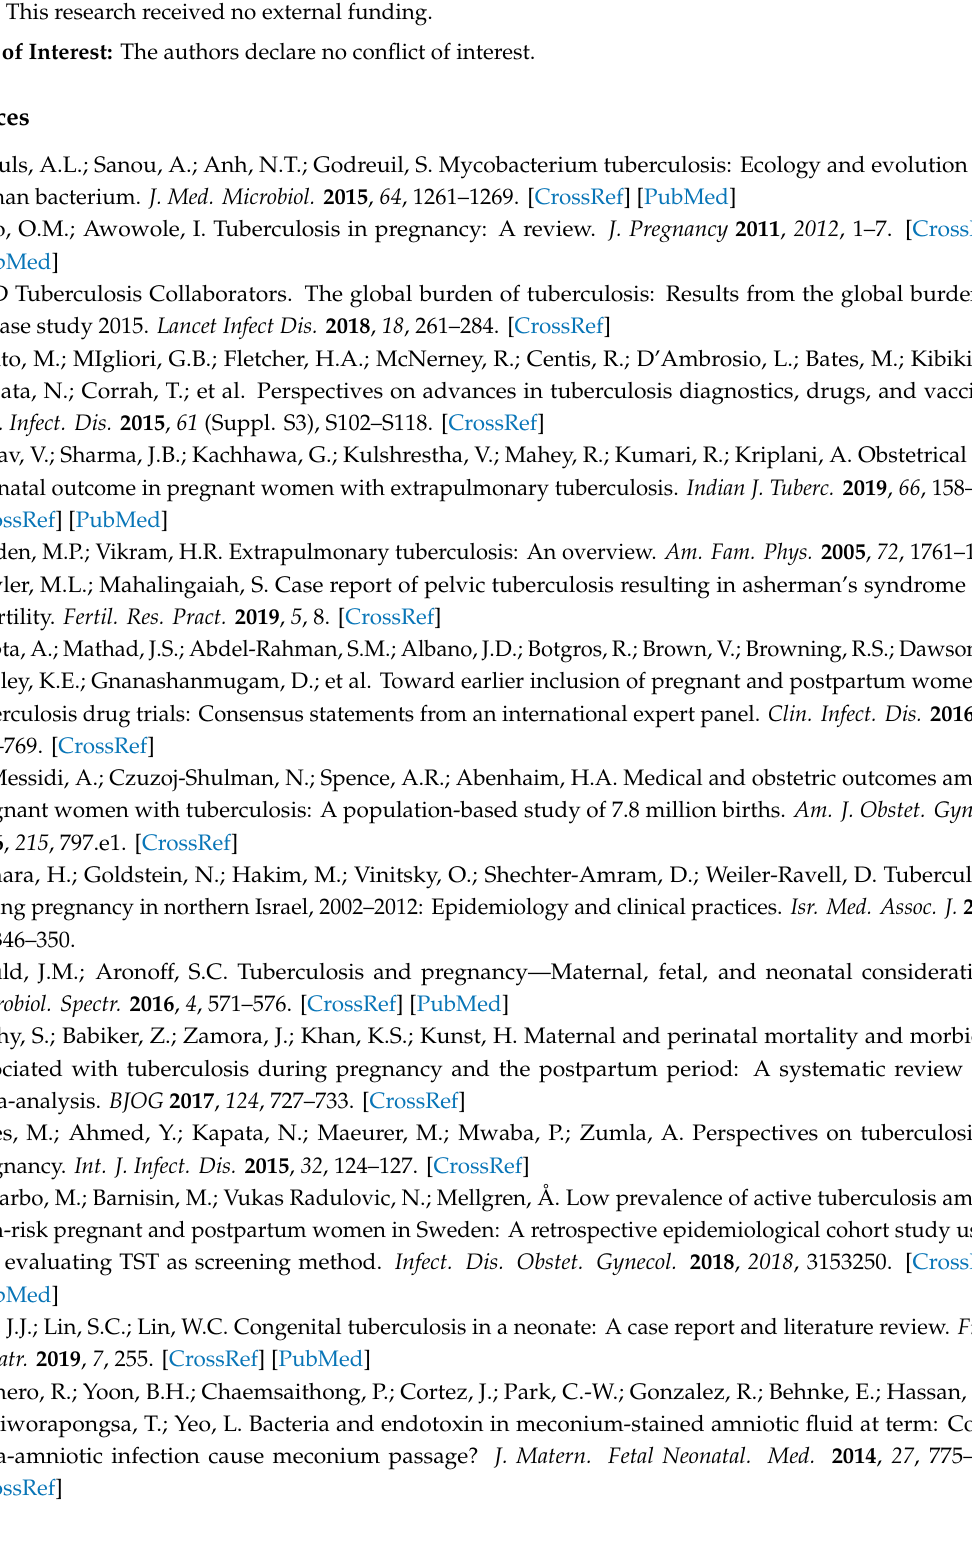
Table S1: Codes of Infectious